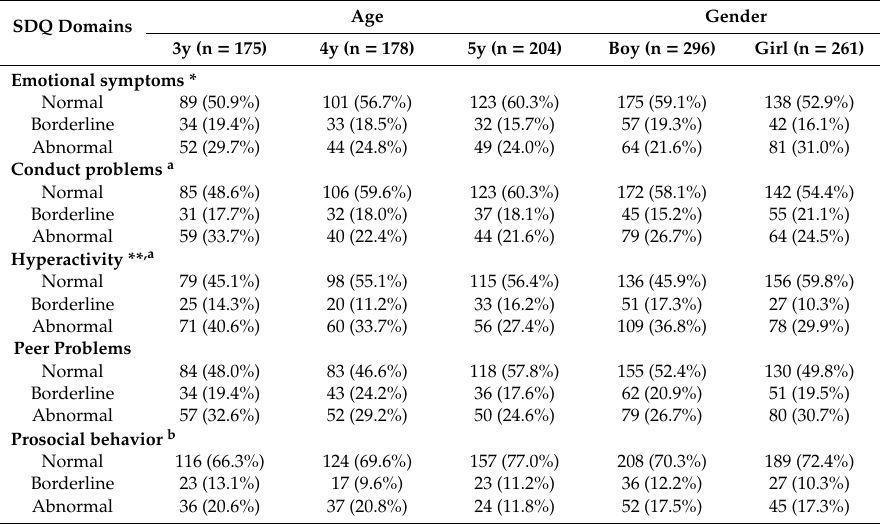
Table 2. SDQ domain among rural LBC by age and gender.